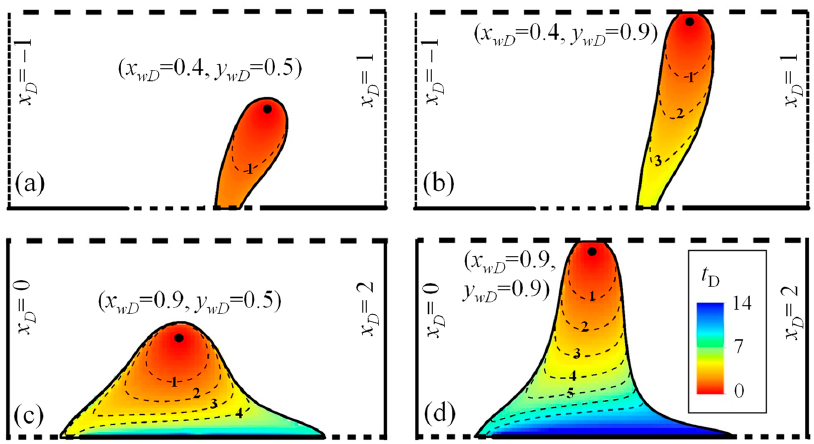
Figure 12. Travel time ( t D , dimensionless) distribution in the catchment zone: ( a ) type-I; ( b ) type-II; ( c ) type-III; ( d ) type-IV. Dashed lines are the contours of t D . Parameter values are specified in the model as α = 0.4, β = 1, γ = 1, λ = 0.2.